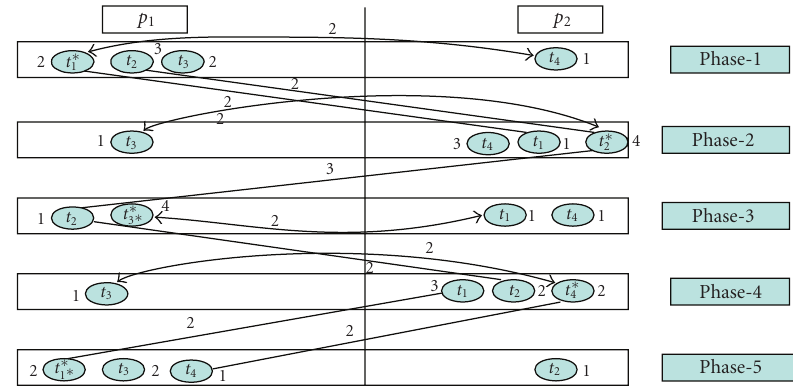
Figure 2: Optimal assignment graph (TCOST =